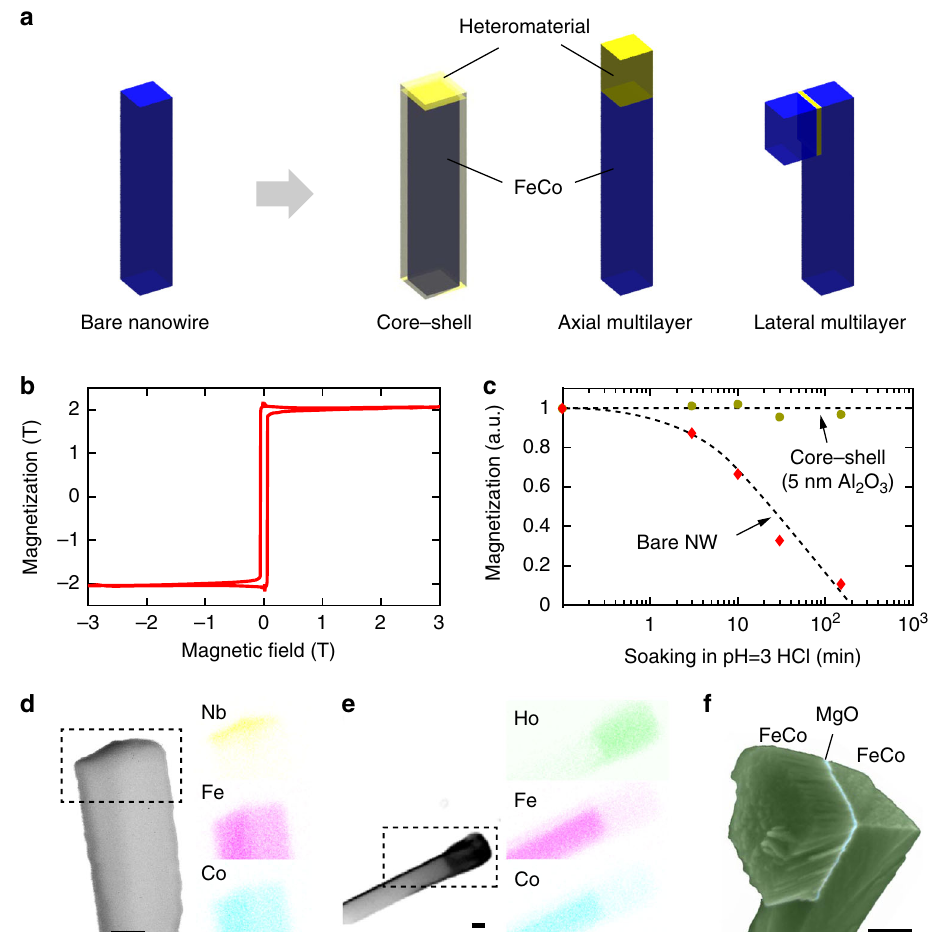
Fig. 5 Hybrid nanowires. a Cartoon illustrating bare, core – shell, axial hybrid, and lateral hybrid nanowires. b Magnetization curve of a single 〈 100 〉 FeCo nanowire measured by dynamic cantilever magnetometry 18 along the easy axis. The saturation magnetization μ 0 M sat (cid:4) 2 : 0 ± 0 : 2 T is considerably higher than that reported for other free-standing tips 17 . c Magnetization of nanowires following immersion in an acidic medium (pH = 3, HCl). Complete degradation is observed for free FeCo nanowires. Conversely, as little as 5 nm of conformal atomic-layer deposited (ALD) alumina completely protects the magnetic nanowires against degradation. d , e Secondary electron images and energy-dispersive X-ray spectroscopy images (colored insets) for Nb – FeCo and Ho – FeCo axial hybrids. Scale bars are 100 nm. f False-color SEM micrograph of a lateral FeCo hybrid with a 5 nm MgO interlayer. Scale bar is 100